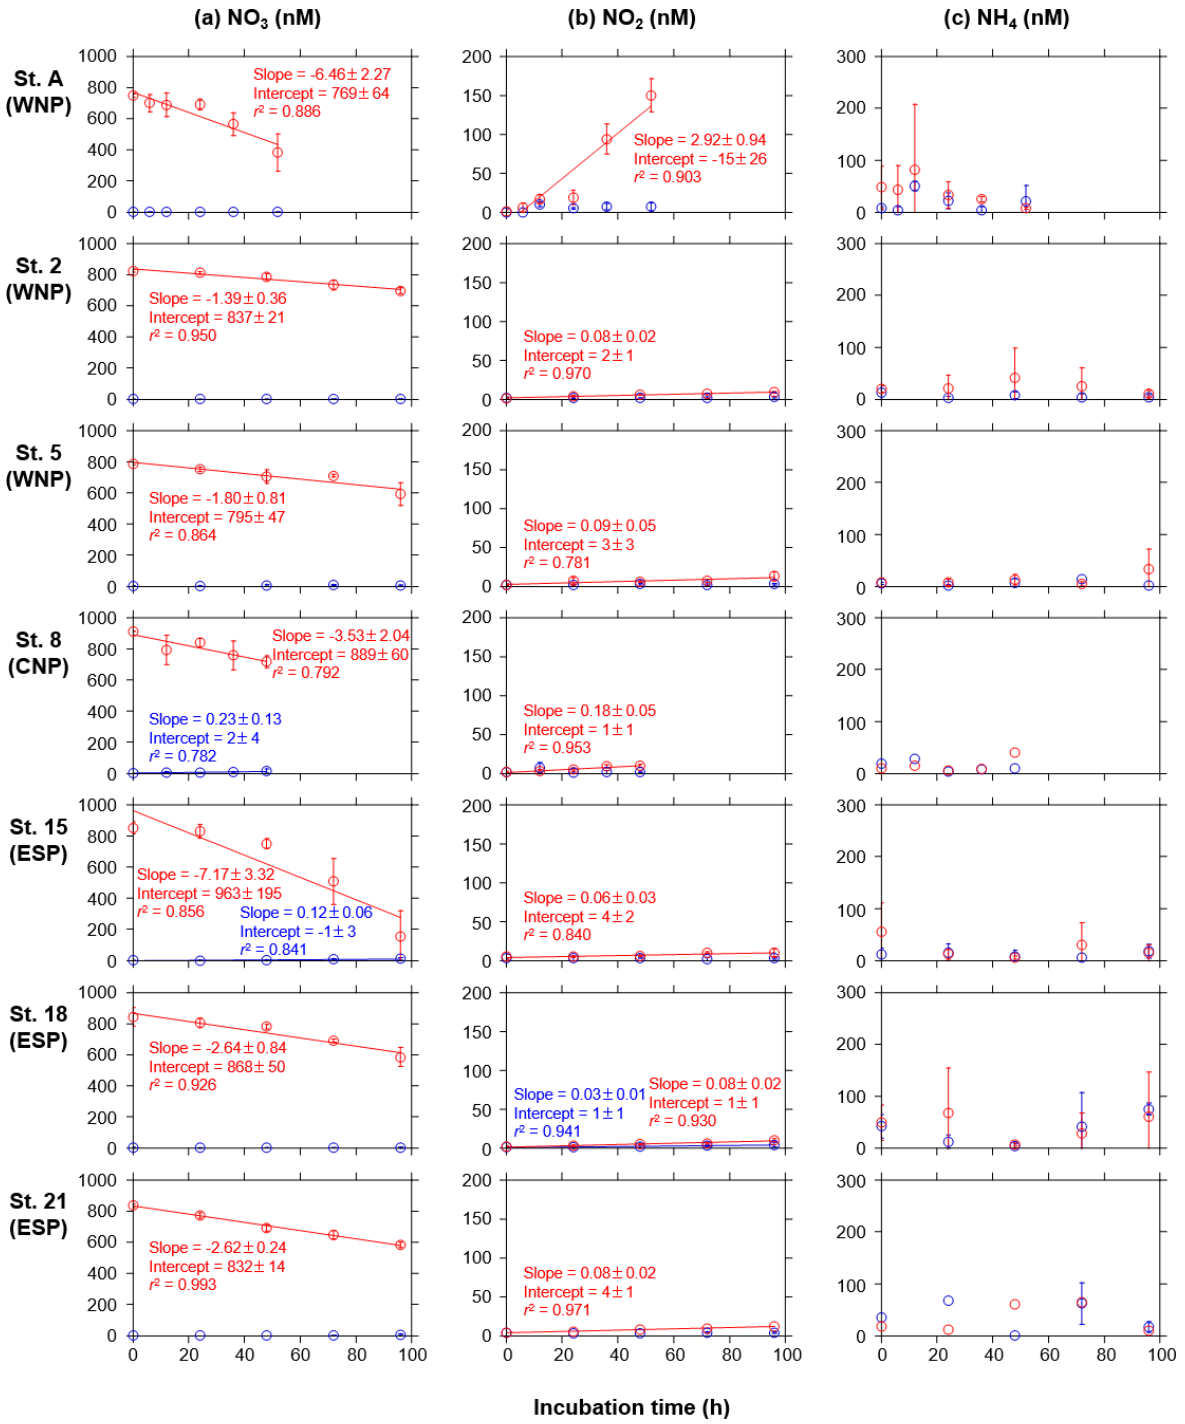
Figure A1. Temporal changes in concentrations of (a) NO 3 , (b) NO 2 , and (c) NH 4 in the control (blue) and treated (red) bottles during the incubation periods at seven stations. Error bars denote standard deviations ( n = 3). Duplicate or single data are denoted as mean or single values without error bars. Linear regression lines are depicted when significant decreases or increases ( p < 0 . 05) in the mean concentrations against time were observed. Errors of slope and intercept represent 95% confidence